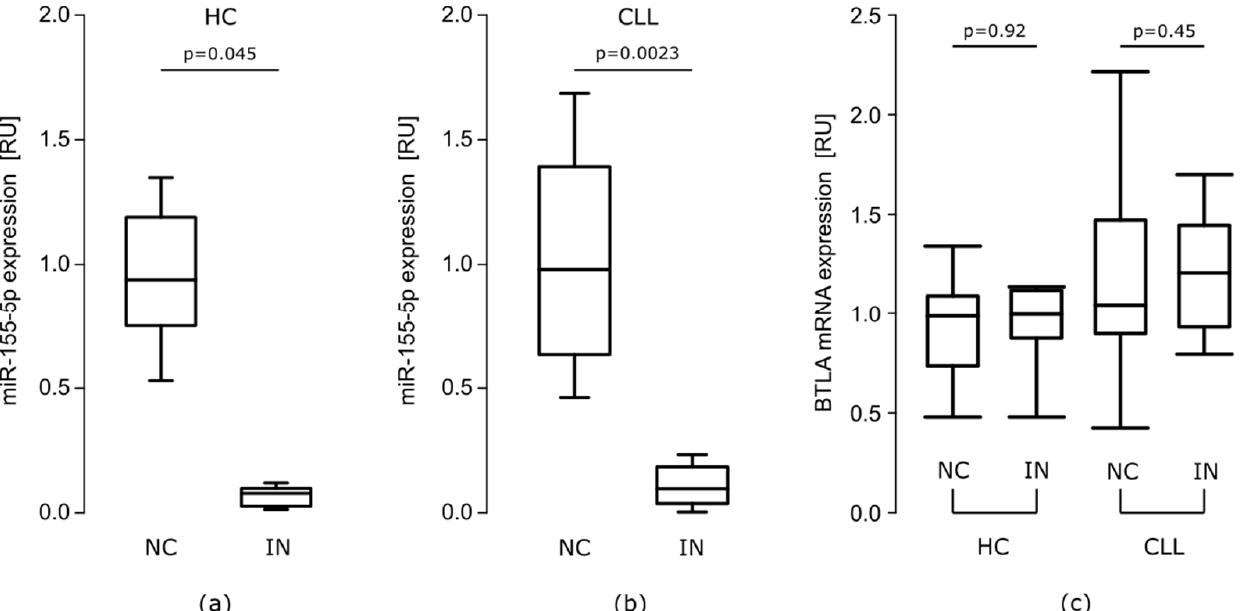
Figure 3. The effect of miR-155-5p inhibition. RT-qPCR analysis showed decreased expression level of miR-155-5p ( a ) in healthy controls (HC) PBMCs ( n = 15) ( p = 0.045, Mann–Whitney test) ( b ) in CLL PBMCs ( n = 20) ( p = 0.0023, Mann–Whitney test) after transfection with miR-155-5p IN. ( c ) Transfection with miR-155-5p inhibitor did not affect BTLA mRNA expression in both HC ( n = 15) and CLL ( n = 20). The central line shows the median, whiskers represent from the first quartile to the third quartile; IN- inhibitor, NC—negative control.